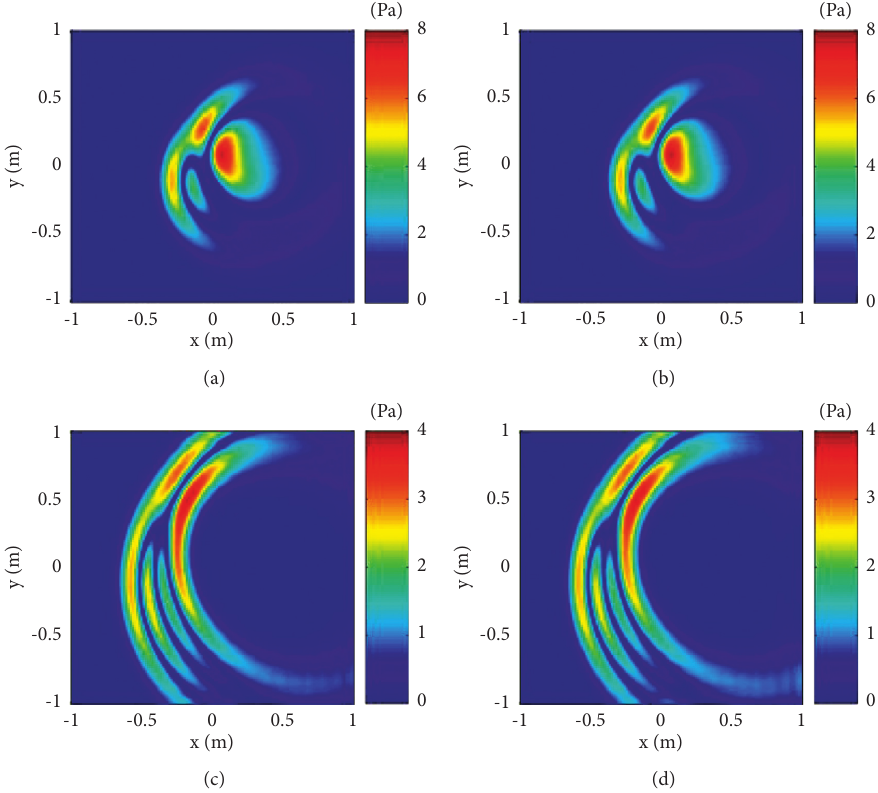
Figure 6: The theoretical and calculated pressures on the prediction plane z (a) and 250 Δ t (c) and the calculated pressures at 150 Δ t (b) and 250 Δ t (d).